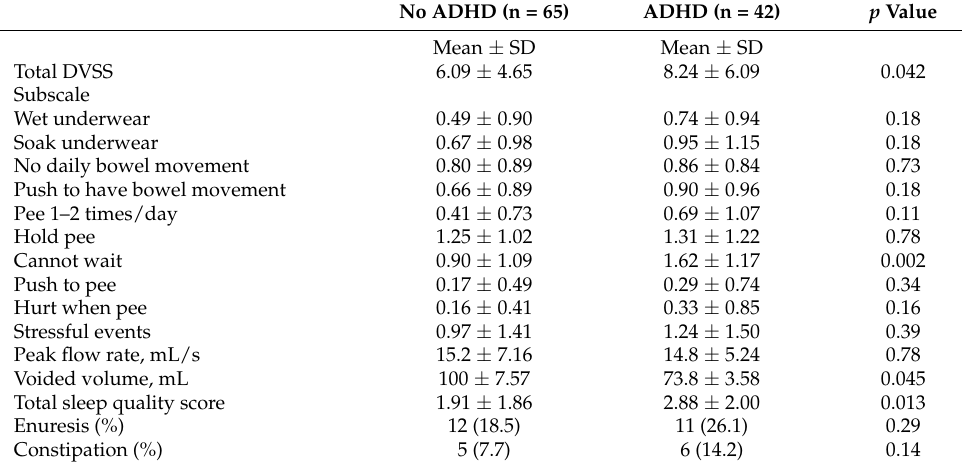
Table 2. The comparison of Dysfunctional Voiding Symptom Scale (DVSS) and flow rates of school- age children, with ADHD versus no ADHD in the hospital-based cohort.